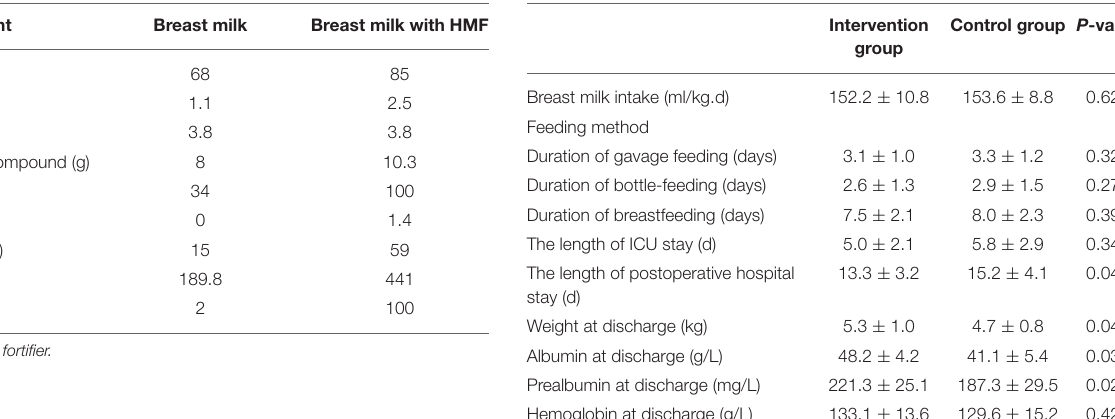
TABLE 1 | The main nutrients of the two milk formulas (per 100ml).